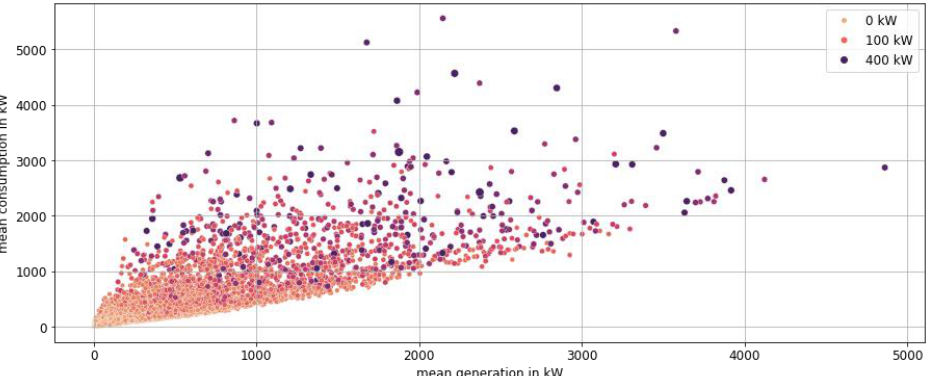
Figure A4. MAE of the trained ML model (demand) depending on mean generation and consumption within each municipality in the test set.